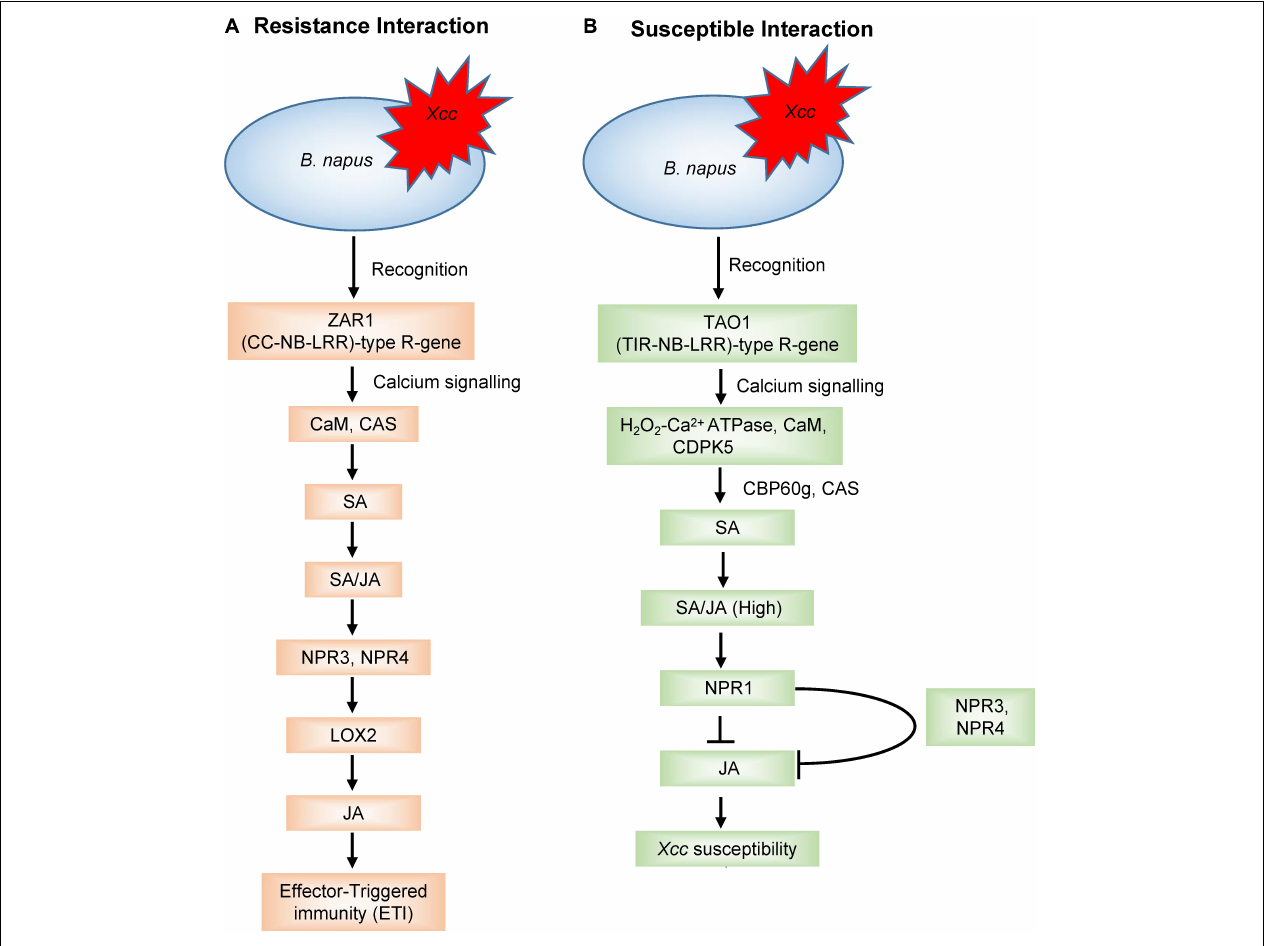
FIGURE 3 | A model outlining the R-gene-mediated signalling to (A) induce effector-triggered immunity (ETI) and (B) disease susceptibility upon Xcc inoculation in Brassica napus as proposed by Mamun et al. (2020). JA, jasmonic acid; SA, salicylic acid; CaM, calmodulin; CAS, calcium-sensing receptor; NPR1, non-expressor of pathogenesis-related gene 1; NPR3, non-expressor of pathogenesis-related genes 3; NPR4, non-expressor of pathogenesis-related genes 4; LOX2, lipoxygenase 2; CDPK5, calcium-dependent protein kinase 5; CBP60g, calcium-sensing protein 60